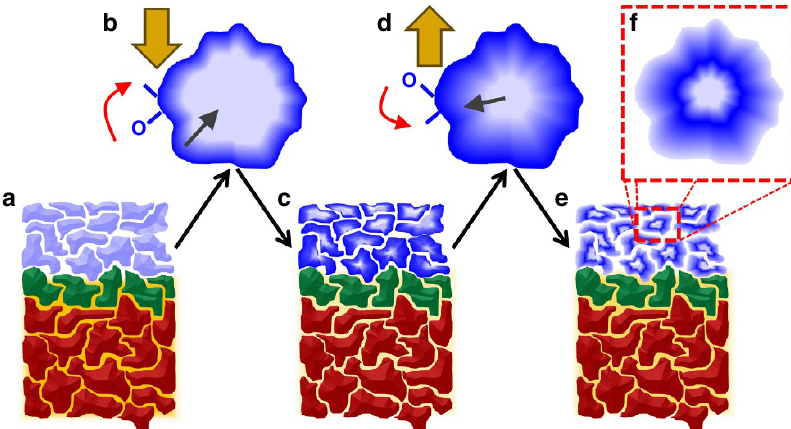
Figure 5 | Illustration of oxygen migration mechanism. Cross-section view of ( a ) the as-grown film, ( b ) a single grain during þ 40V treatment, ( c ) the film after þ 40V treatment, ( d ) a single grain during subsequent (cid:2) 40V treatment, and ( e , f ) cross section and grain after (cid:2) 40V treatment. Colours identify AlO x (red), GdO x (green), metallic FM Co (light blue), insulating non-FM CoO x (blue) and interstitial oxygen (orange); large gold arrow indicates the electric field. Illustration emphasizes fast surface migration, identified by the red arrows, and slow bulk diffusion, indicated by the grey